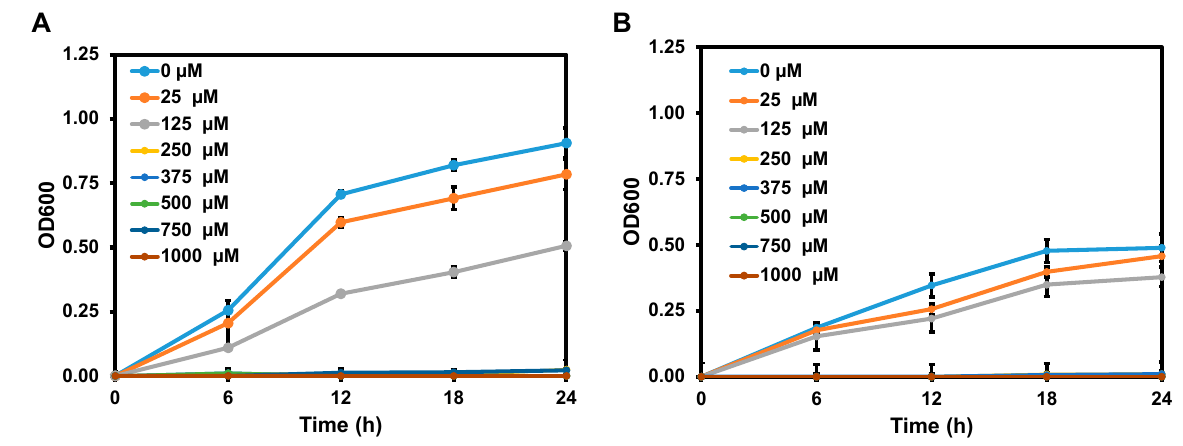
Figure 7. Growth curves of E. coli 780 ( A ) and S. aureus 1466 ( B ) in response to 3d in a time course of 24 h.